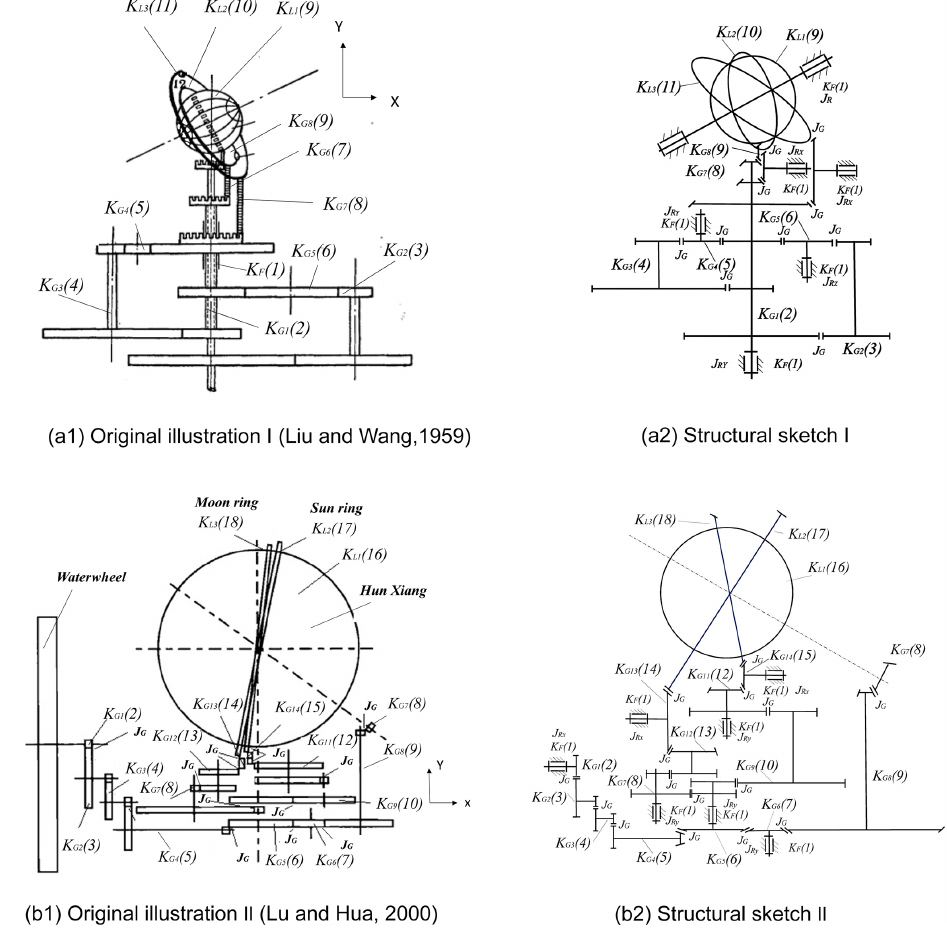
Figure 1. Gear drive systems of the water-powered celestial globe by Liu Xian-Zhou, namely (a) type I (Liu and Wang, 1959) and (b) type II (Lu and Hua,